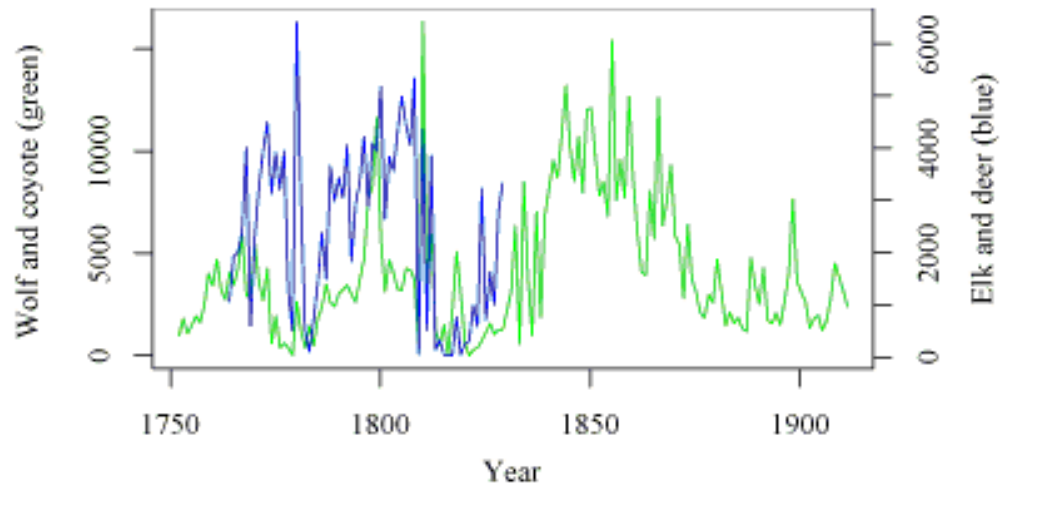
Fig. 2. Hudson's Bay Company records of wolf and coyote, and elk and deer pelt returns (from Turchin